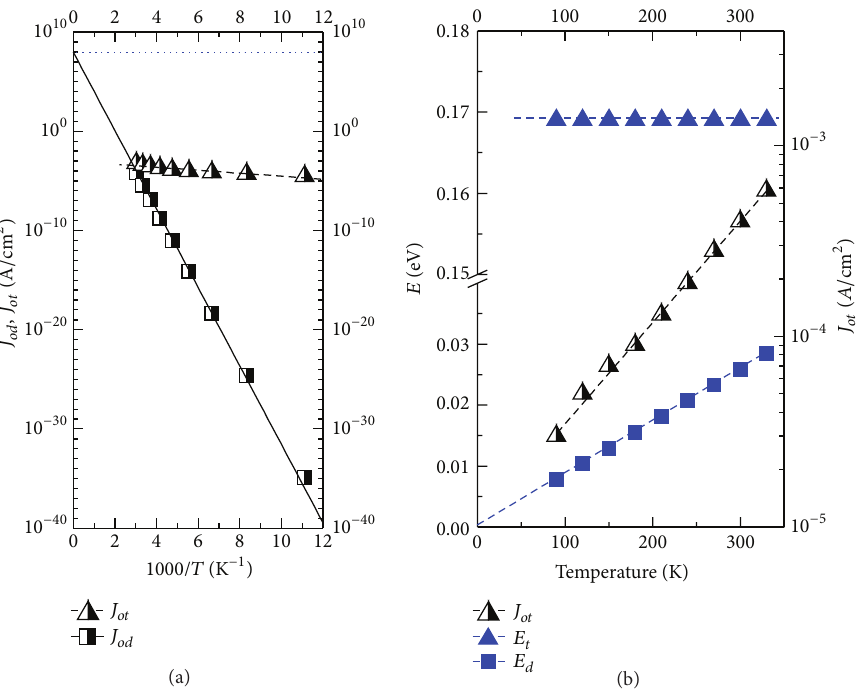
Figure 7: Dependencies of the Ge “subcell” diode parameters of diffusion ( 𝐸 𝑑 , 𝐽 𝑜𝑑 ) and tunneling ( 𝐸 𝑡 , 𝐽 𝑜𝑡 ) current components on the value of inverse (a) and forward (b) absolute